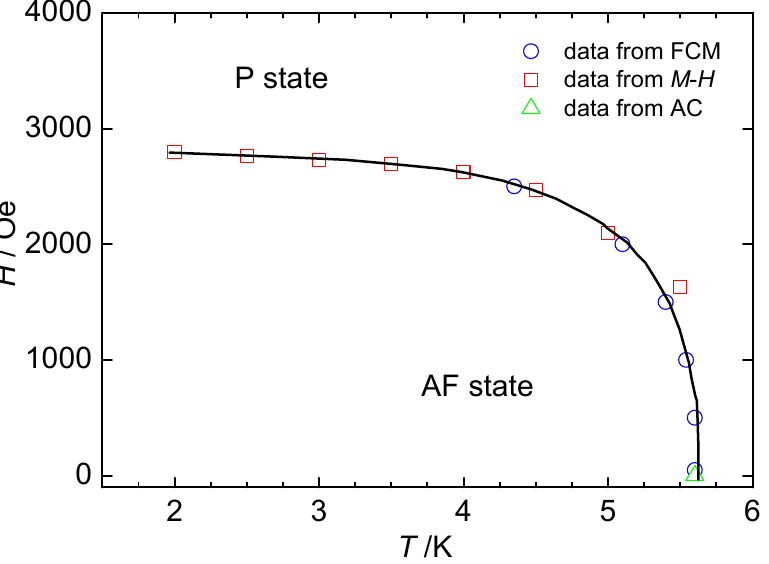
Figure 7. Temperature vs. field magnetic phase diagram of 1 . The open blue cycles, open red squares, and open green triangle are data from the locations of maximum in FCM data, dM / dH vs. H data, and χ M ′ in ac data; the solid line is to guide the eye.